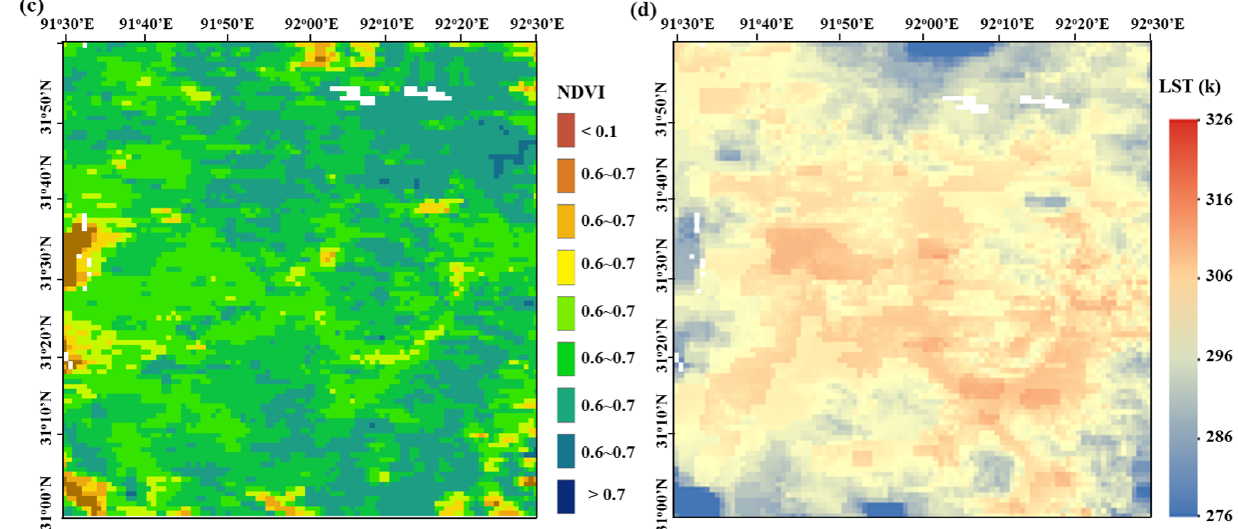
Figure 6. Spatial distribution of surface soil moisture estimated from: ( a ) the Inverse Distance Weighting (IDW) method; ( b ) the trapezoidal method for 2September 2010. The spatial patterns of concurrent normalized difference vegetation index (NDVI) and LST are shown in ( c ) and ( d ), respectively. Blank pixels in ( b )–( d ) indicate either water surfaces or cloudy areas.